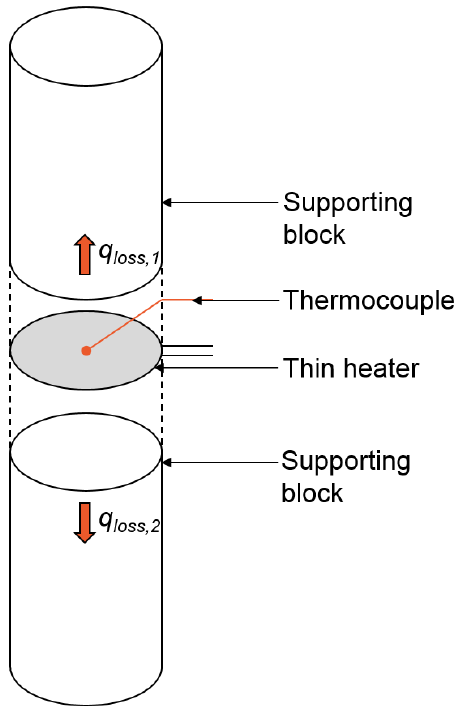
Figure A1. Schematic diagram of experimental setup for heat loss measurement.